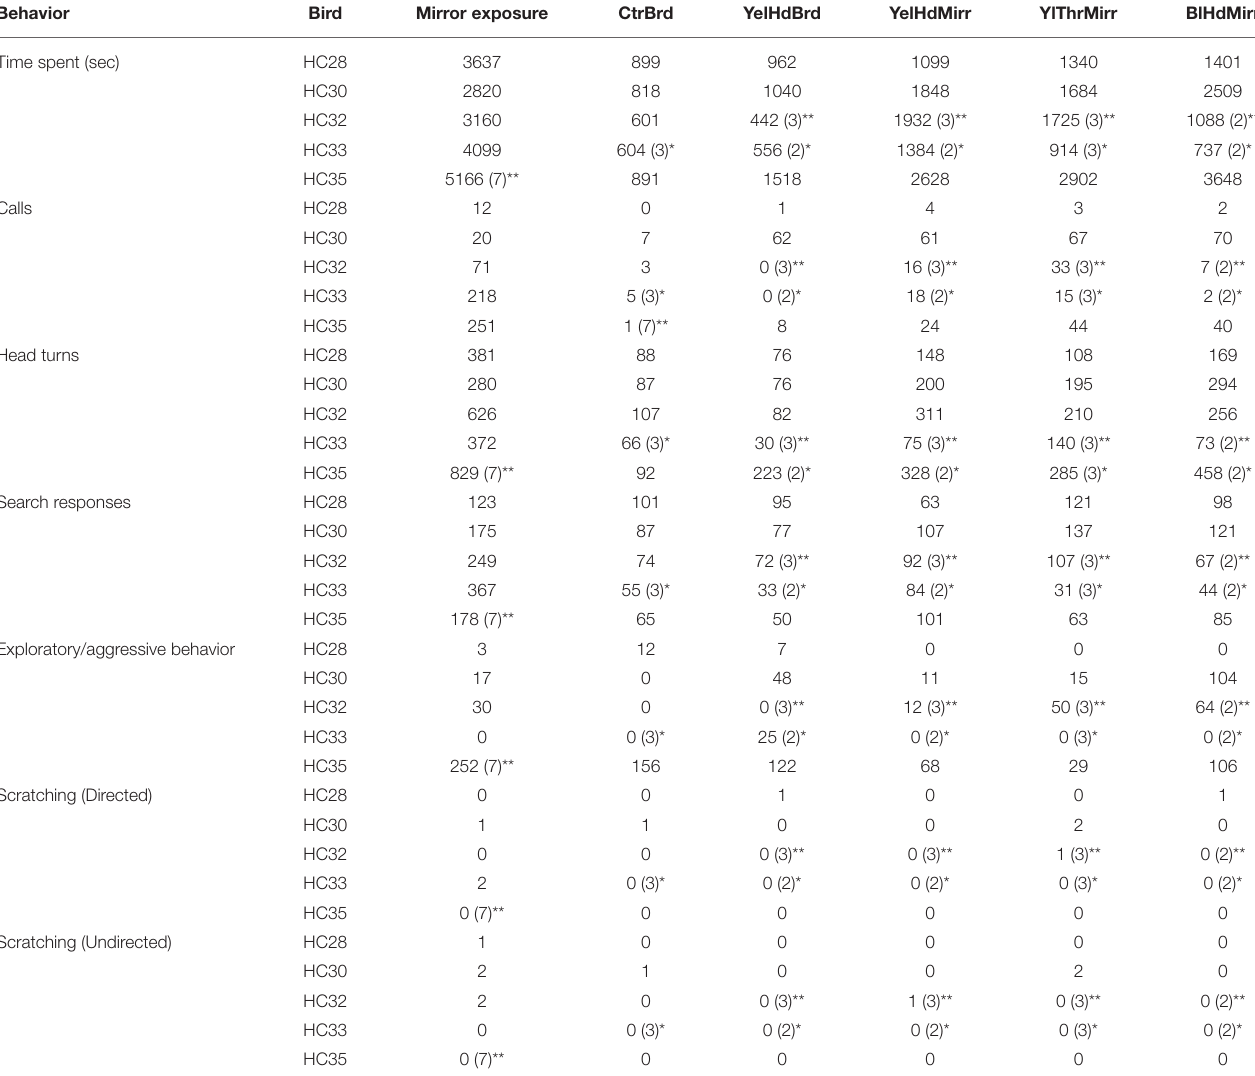
TABLE 2 | Quantitation of different behaviors performed by Indian house crows during mirror self-recognition. Behavior Bird Mirror exposure CtrBrd Time spent